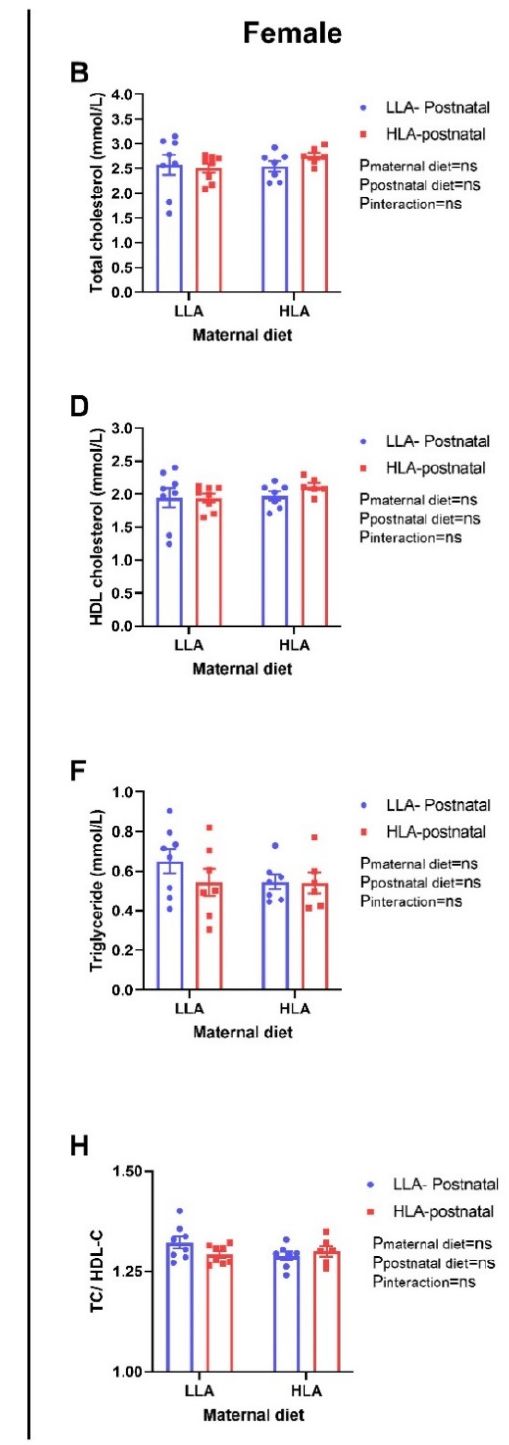
Figure 8. Effect of a maternal and postnatal diet high in linoleic acid on circulating lipid profile in adult offspring. Data are presented as mean ± standard error of the mean (SEM). Two-way ANOVA was performed for statistical analysis with maternal diet and postnatal diet as two factors. n = 5–8. LLA: low linoleic acid; HLA: high linoleic acid; PN: postnatal; TC: total cholesterol; HDL-C: high-density lipoprotein- cholesterol. A : Total cholesterol concentration male; B : Total cholesterol concentration female; C : HDL concentration male; D : HDL concentration female; E : Triglyceride concentration male; F : Triglyceride concentration female; G : Total cholesterol: HDL concentration male; H : Total cholesterol: HDL concentration female.